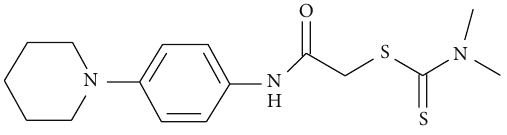
Figure 2: Chemical structure of compound 4a